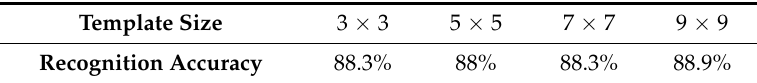
Table 1. Influence of filter template size on recognition